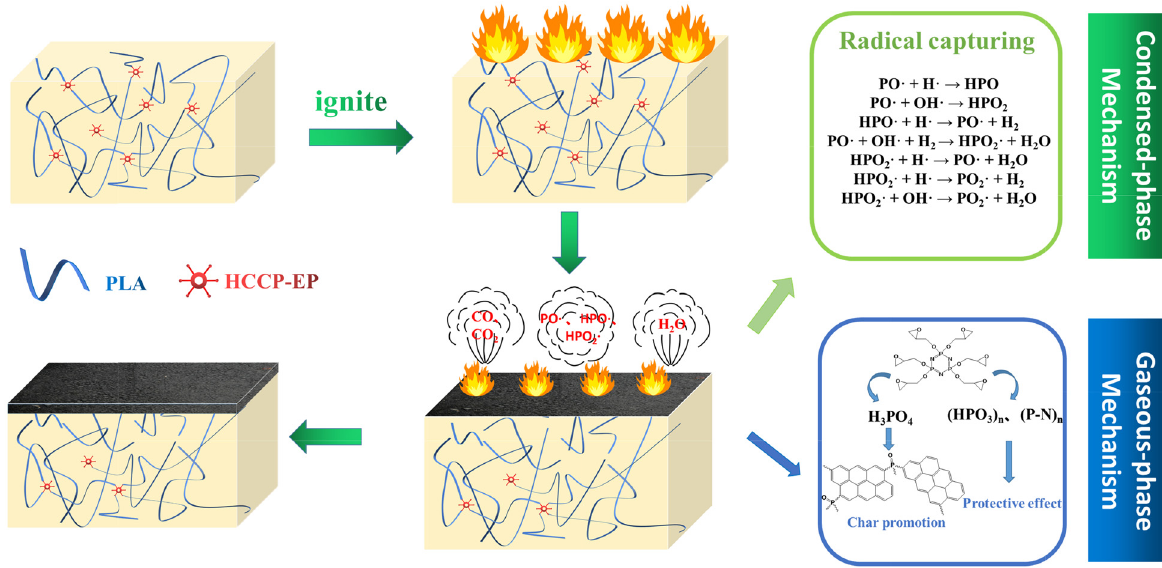
Figure 8: The fl ame - retardant mechanism of HCCP -